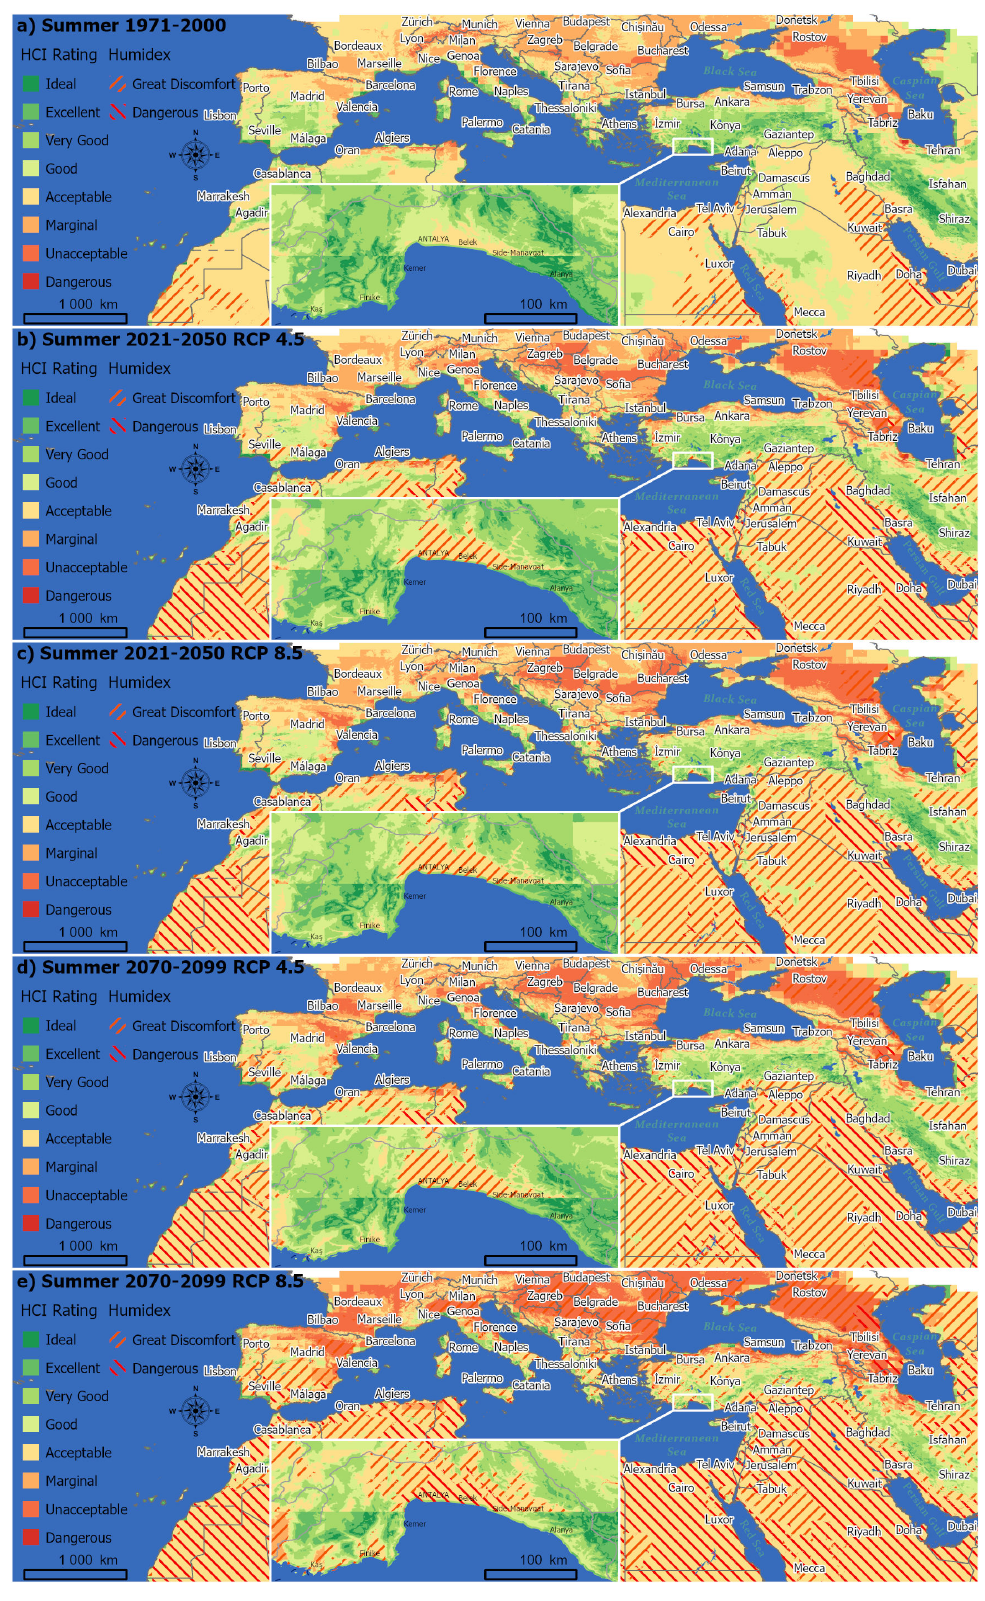
Figure 6. Summer season Holiday Climate Index (HCI) ratings and Humidex risks in the greater Mediterranean region for the projection periods ( a ) 1971–2000 ( b ) 2021–2050 (RCP 4.5) ( c ) 2021–2050 (RCP 8.5) ( d ) 2070–2099 (RCP 4.5) ( e ) 2070–2099 (RCP